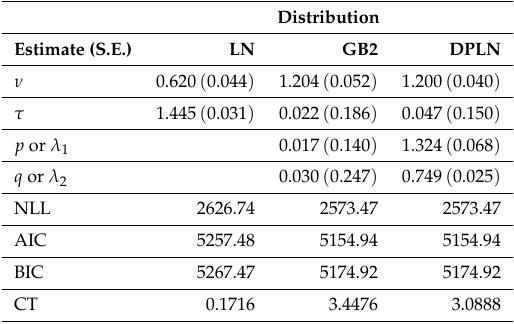
Table 4. Results of fitting the LN, GB2 and DPLN distributions to automobile bodily injury claims data.